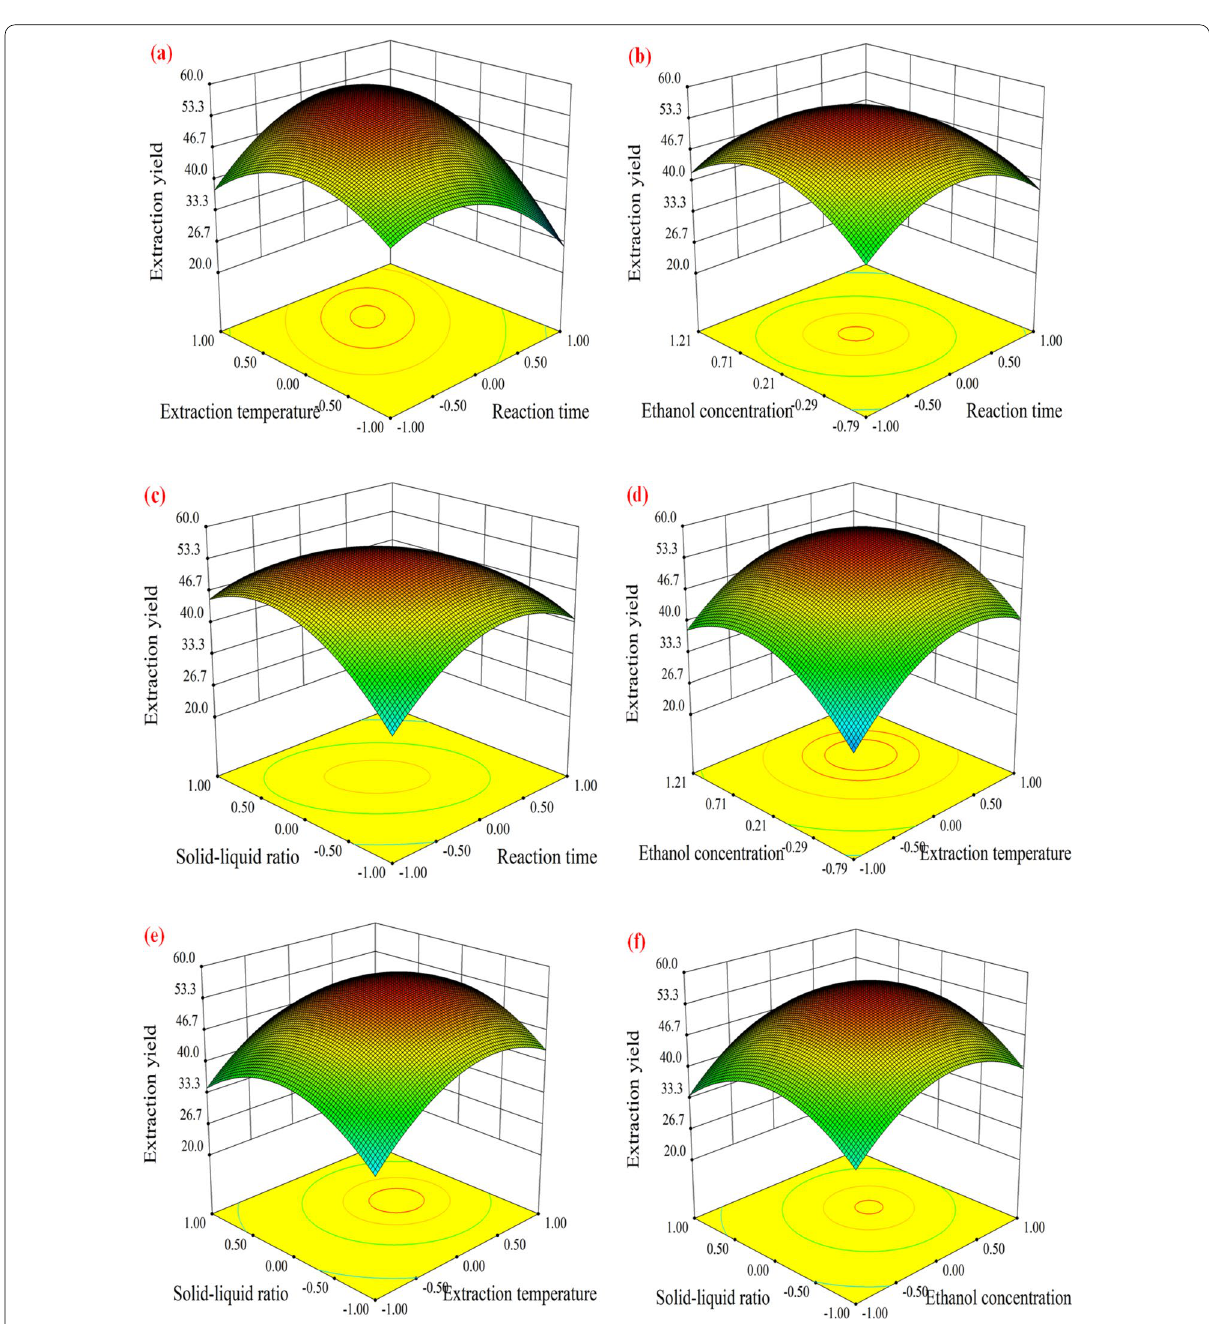
Fig. 6 Effects of different parameters on the yield of lignin extraction from palm fibers using ethanol: interaction effects of the a extraction time and reaction temperature, b extraction time and ethanol concentration, c extraction time and solid/liquid ratio, d reaction temperature and ethanol concentration, e reaction temperature and solid/liquid ratio, and f ethanol concentration and solid/liquid